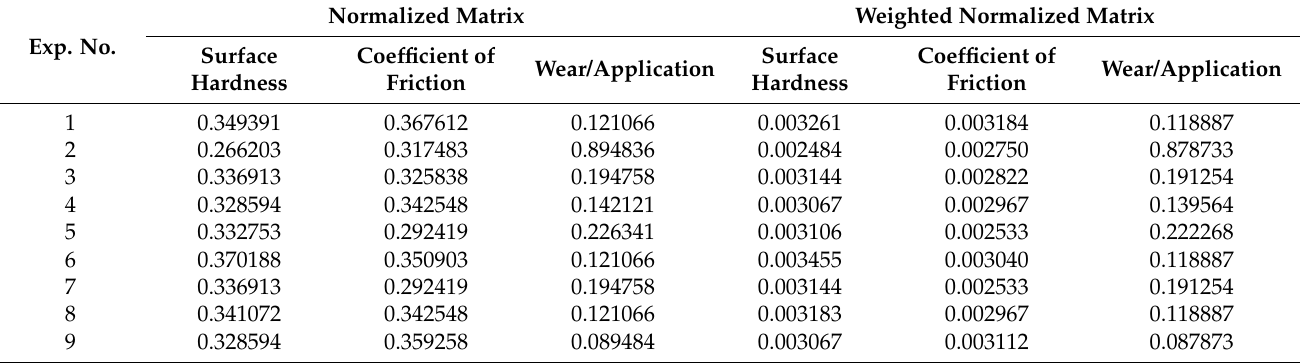
Table 5. Normalized and weighted normalized decision matrixes for case study 2.